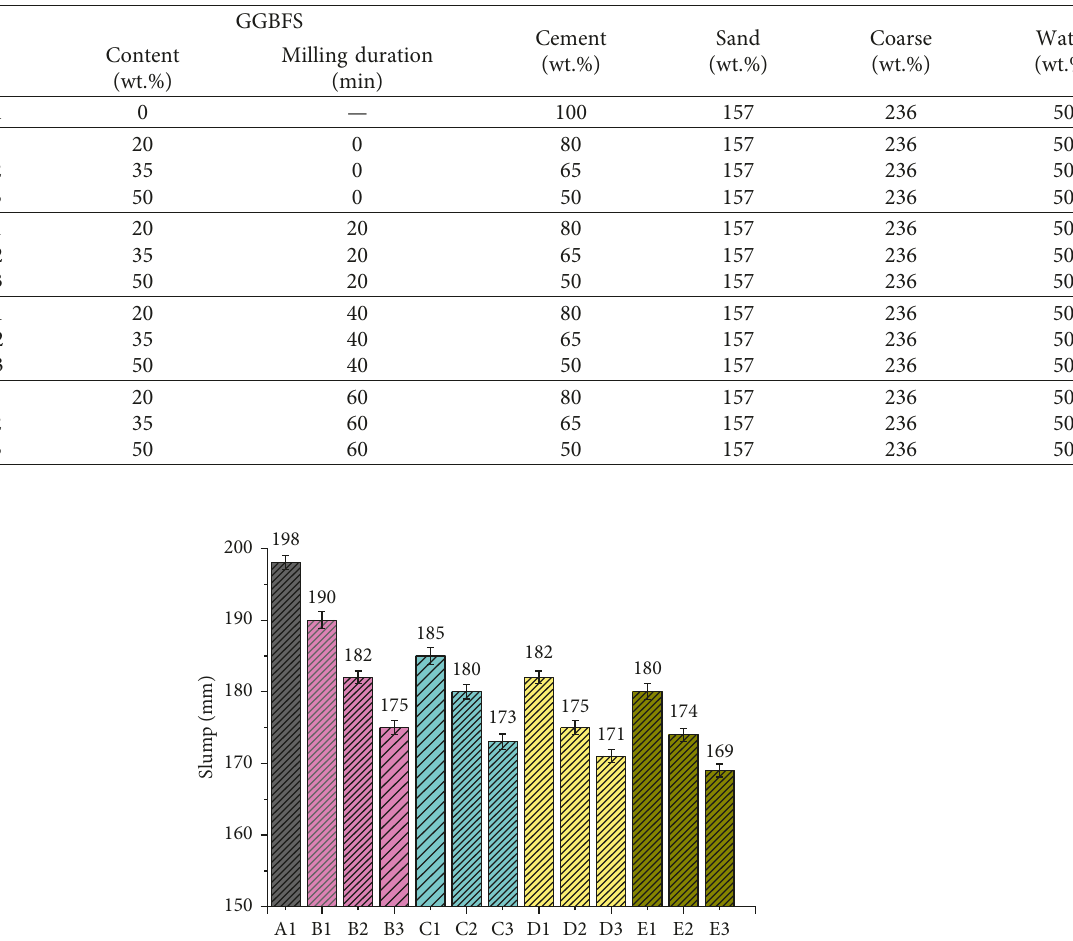
Table 4: Designations of mixtures in this